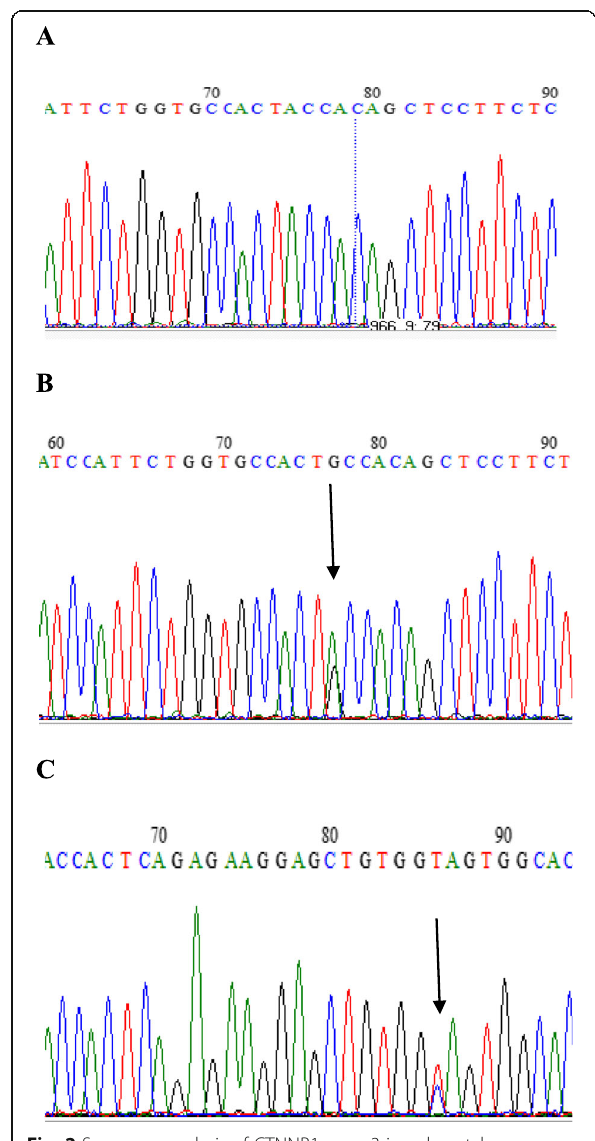
Fig. 2 Sequence analysis of CTNNB1 exon 3 in colorectal cancer tissue and corresponding normal tissue of the same patient. Heterozygous mutation at codon 41 (ACC to GCC) in tumor. Chromatogram of CTNNB1 exon 3, ( a ): DNA from normal tissue with wild type codon ACC (T41) sequenced with forward primer and ( b ) and ( c ): DNA from tumor tissue with heterozygous mutation (ACC> GCC) sequenced with forward